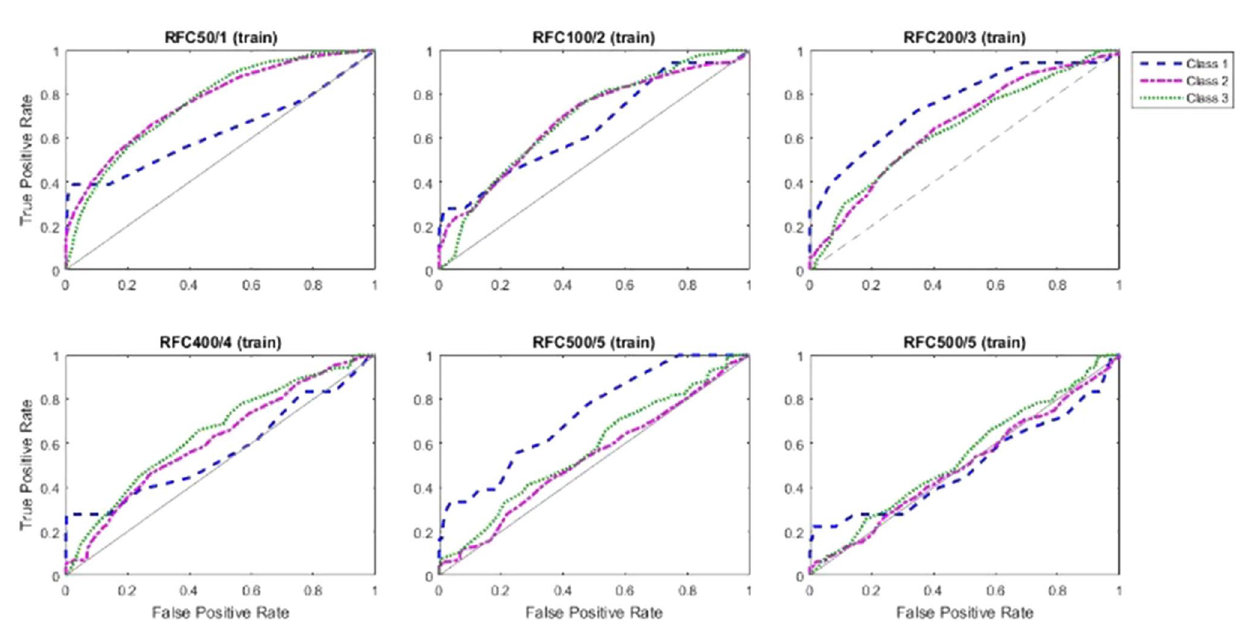
Fig. 6 ROC curve (training) for RFC